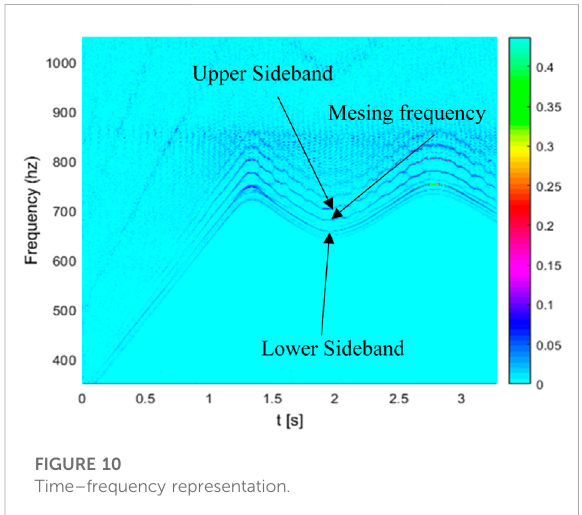
FIGURE 10 Time – frequency